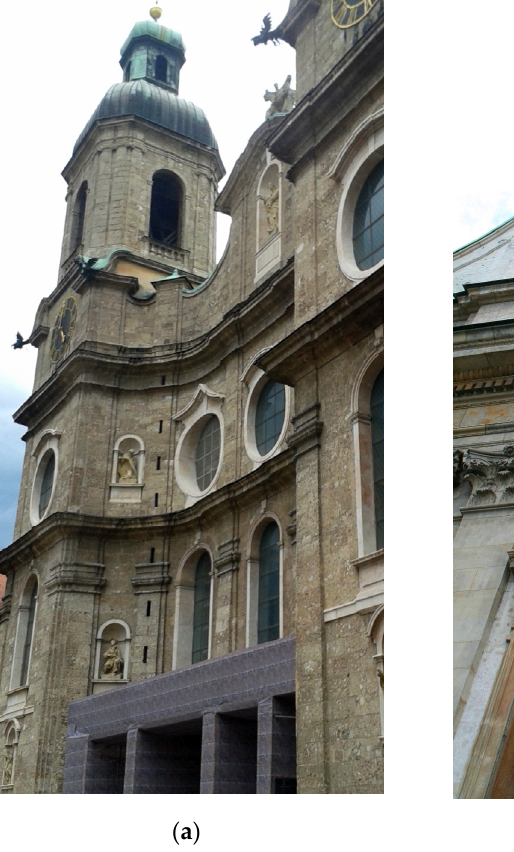
Figure 5. Monochromatic or semi-monochromatic façade: ( a ) the façade of Innsbruck Cathedral of Hötting Breccia ; ( b ) the façade of the church of Saints Peter and Paul in Cracow (1605–1619 to 1630) faced with Dolomite and Jurassic limestones from the region. Photos by author.